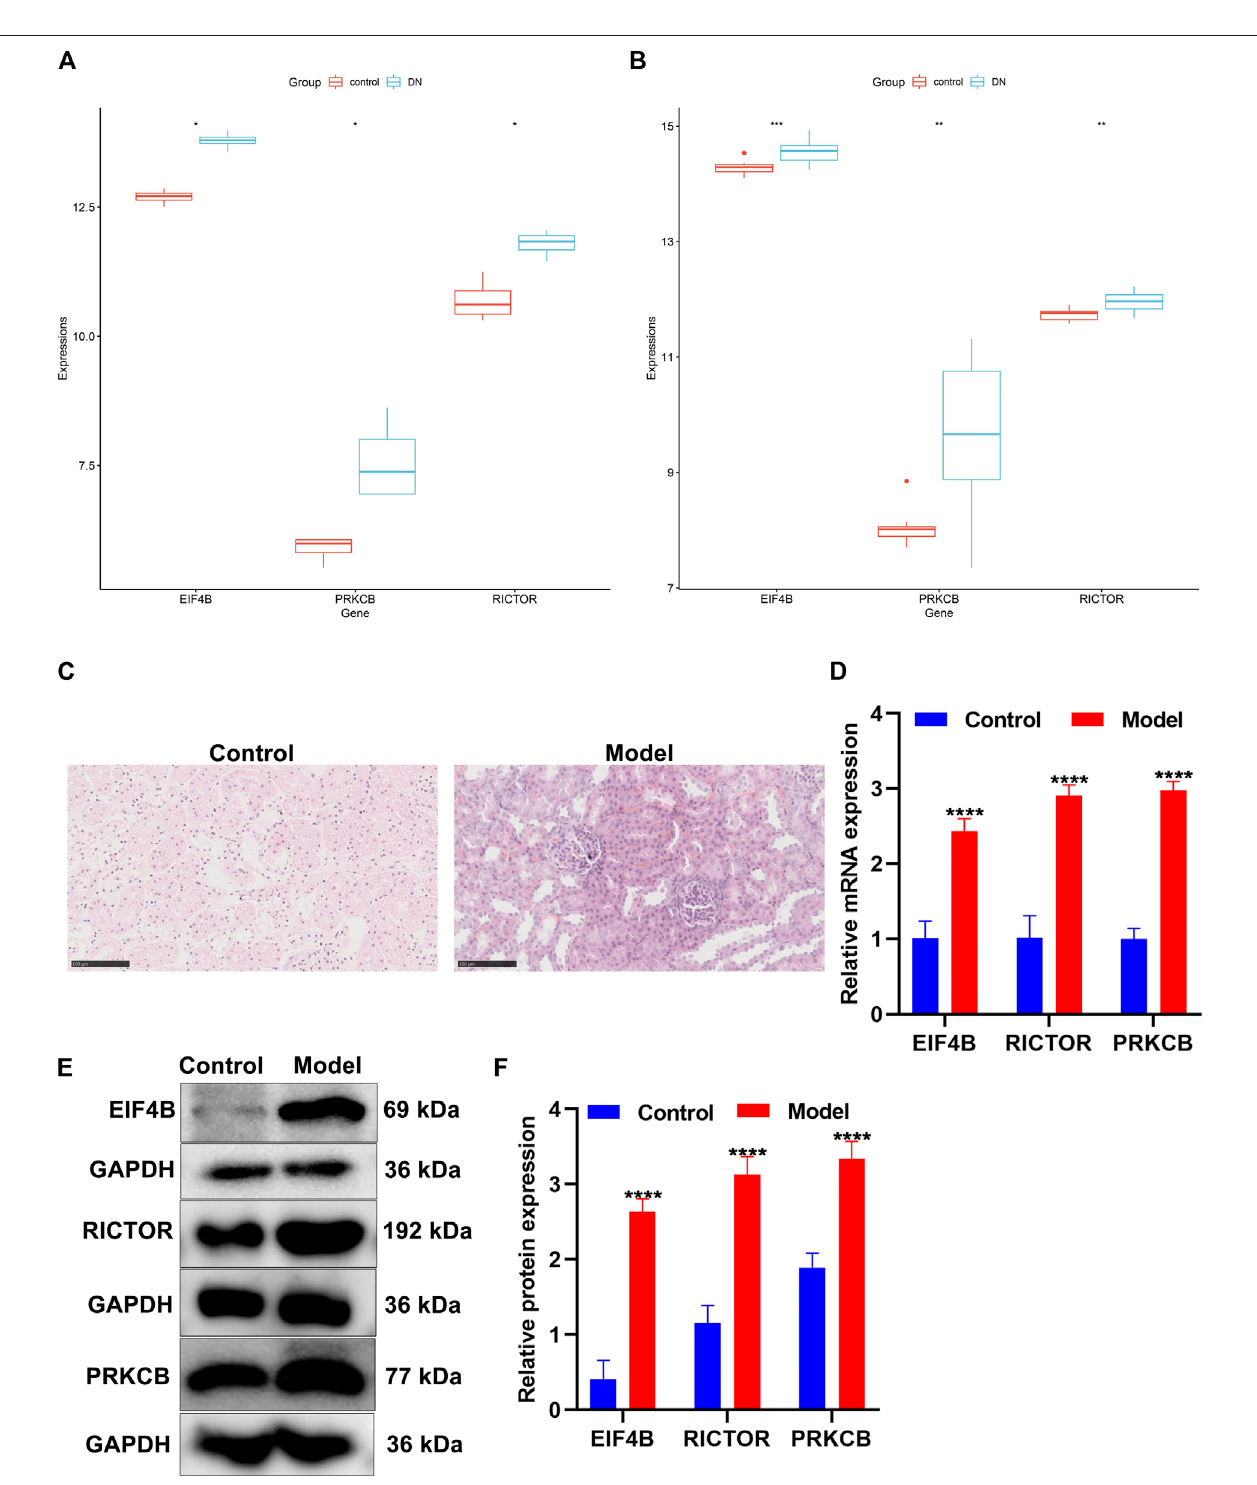
FIGURE 9 | Validation of the expression of the mTOR pathway markers in diabetic nephropathy. (A,B) Box plots of the expression of mTOR pathway markers EIF4B, RICTOR, and PRKCB in control and diabetic nephropathy samples in the (A) GSE111154 and (B) GSE142025 datasets. DN: diabetic nephropathy. (C) H&E stainingofthe morphologyofkidney tissues in thecontrol group and the diabetic nephropathy rat model group. Scale bar,100 μ m; magni fi cation, ×400. (D) The mRNA expression of EIF4B, RICTOR, and PRKCB was determined in kidney tissues from the control and diabetic nephropathy groups through RT-qPCR. (E,F) The expressionofEIF4B,RICTOR,andPRKCBproteinswasdeterminedinkidneytissuesfromthecontrolanddiabeticnephropathygroupsthroughWesternblot.* p < 0.05; ** p < 0.01; *** p < 0.001; **** p < 0.0001.